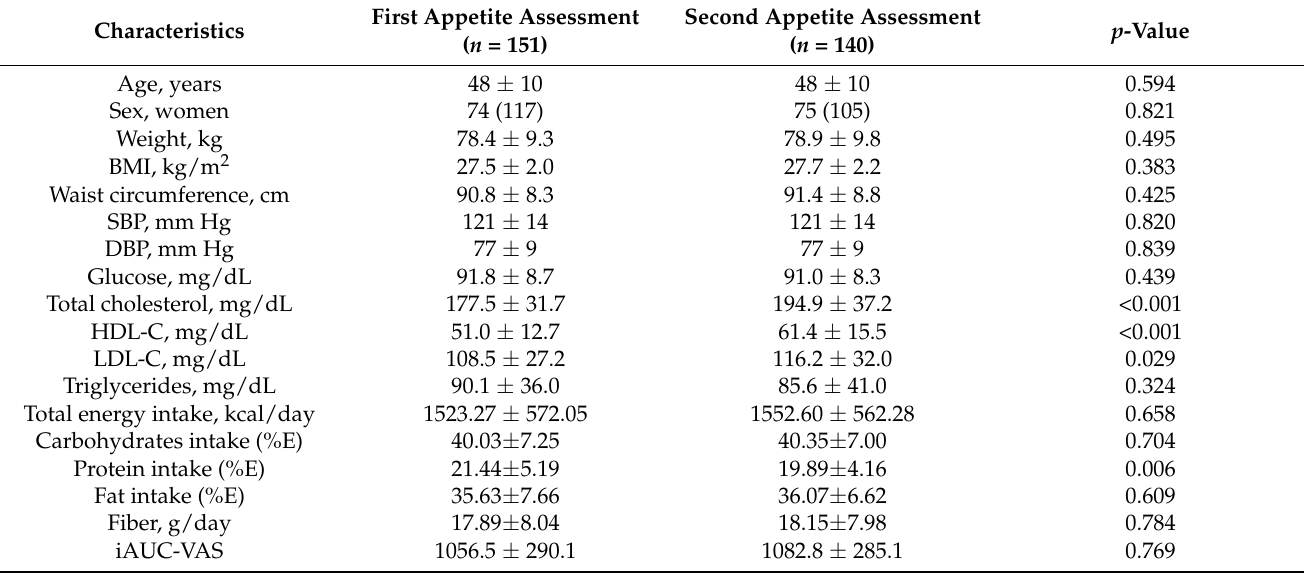
Table 1. Characteristics of the study